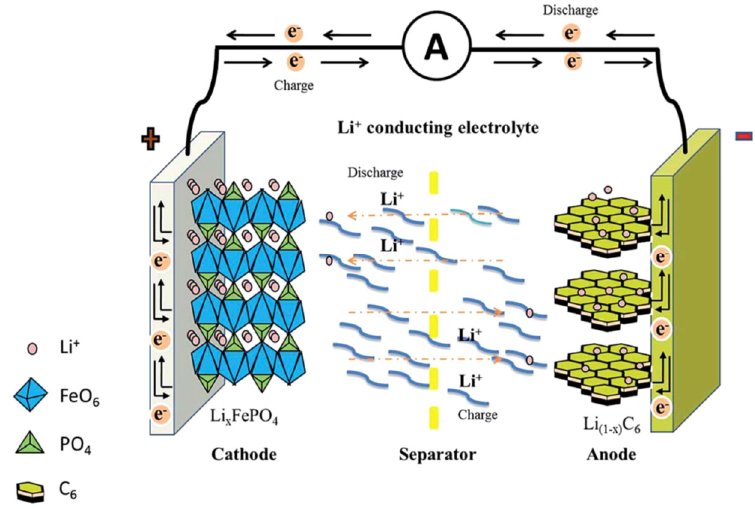
Figure 1. Schematic illustration for the working mechanism of a typical LiFePO 4 cathode-based Li-ion battery. Reproduced with permission from [12]. The Royal Society of Chemistry, 2014.